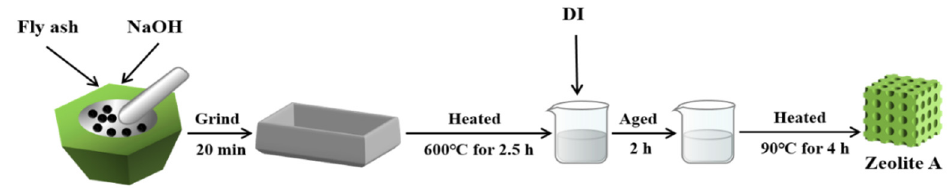
Figure 1. Synthetic diagram of zeolite A.